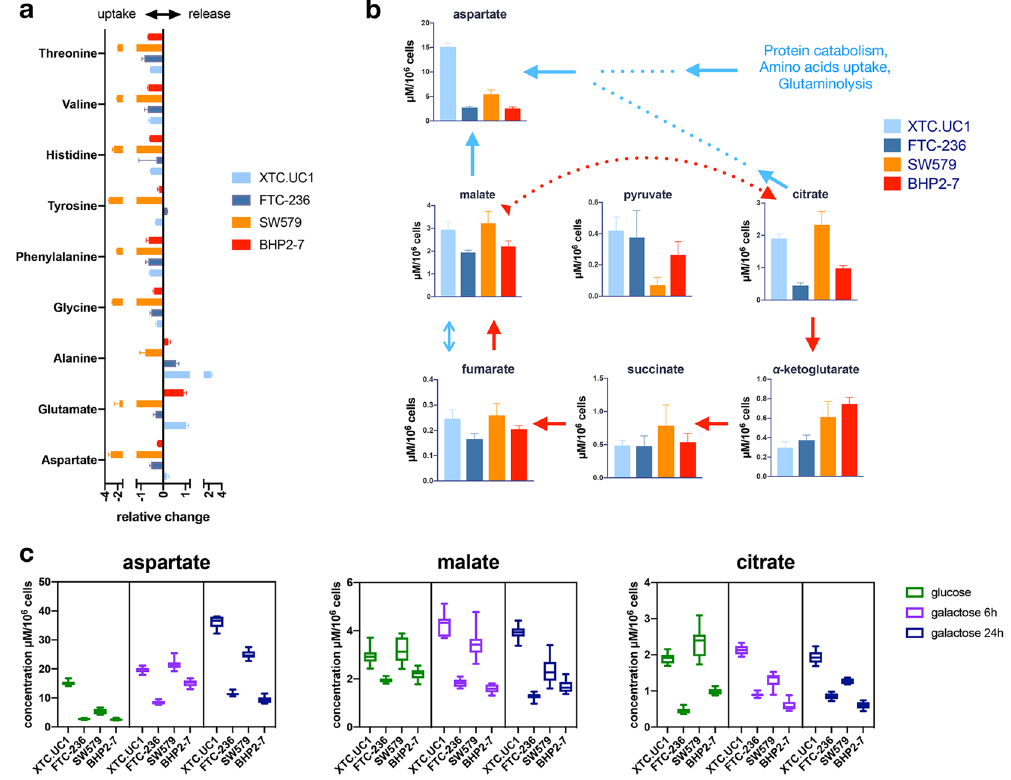
Figure 5. Central carbon metabolism in XTC.UC1, FTC-236, SW579 and BHP2-7 and de novo synthesis of aspartate; ( a ). consumption of nutrients and excretion of metabolic products (expressed as relative change, i.e. μ mol/h/10 6 cells of each metabolite in each cell line divided by the mean of the same metabolite); ( b ). schematic representation of the de novo synthesis of aspartate in the TCCLs and the quantified concentrations of TCA cycle intermediates and aspartate; ( c ). intracellular concentrations of aspartate and its precursors malate and citrate in normal culture medium and in glucose exchange by galactose medium for 6 and 24